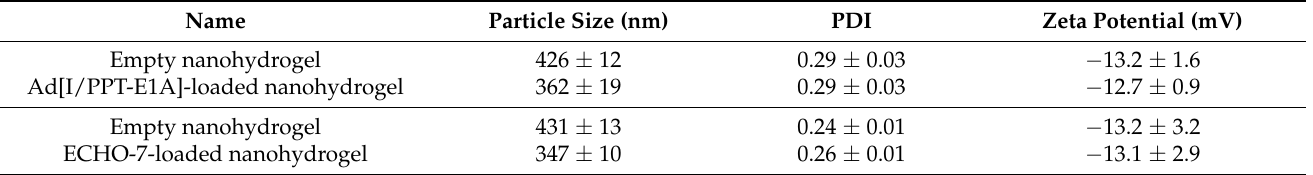
Table 1. Particle size, polydispersity index (PDI) and zeta potential of empty and OV-loaded nanohydrogels characterized by dynamic light scattering (DLS).